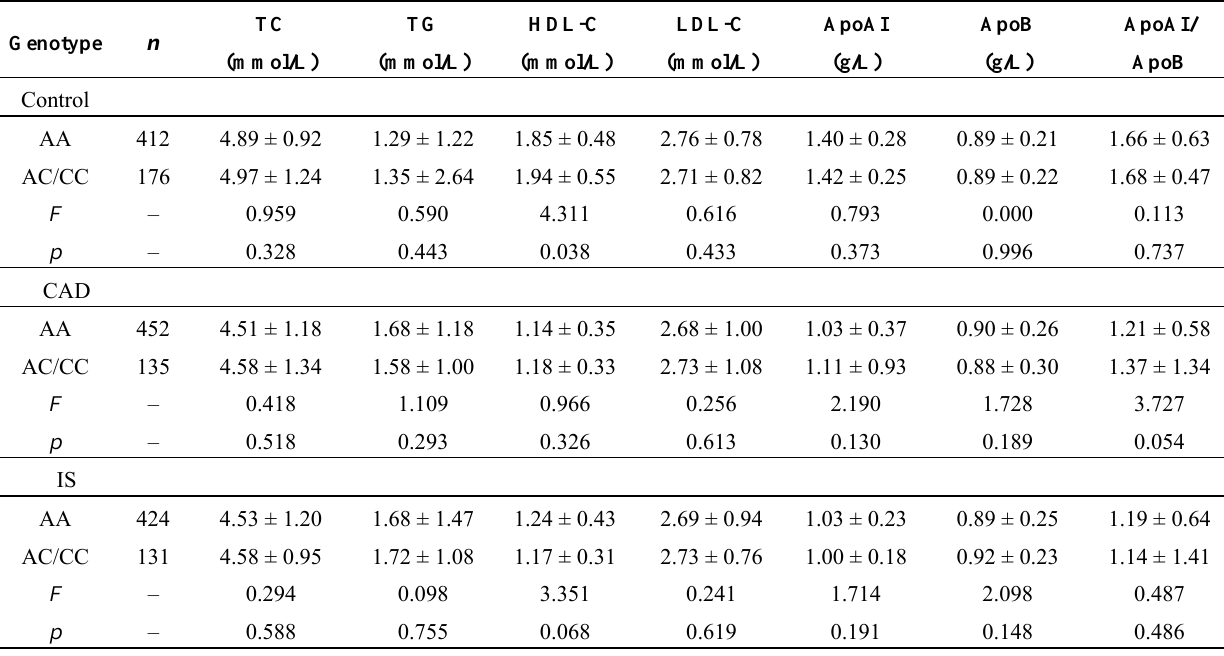
Table 5. Association between rs1044925 and serum lipid levels in controls and CAD and IS